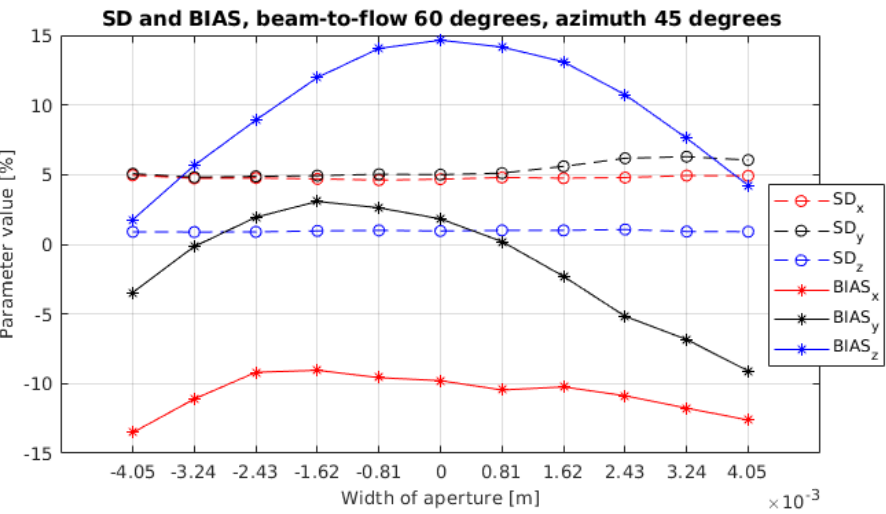
Figure 9. RSD and RB for 60 degrees beam-to-flow angle and 45 degrees rotation angle, all cross planes along the vessel.The dashed lines show the relative standard deviation, the solid lines show the relative bias. The red color is v x , the black is v y and the blue is v z components of the